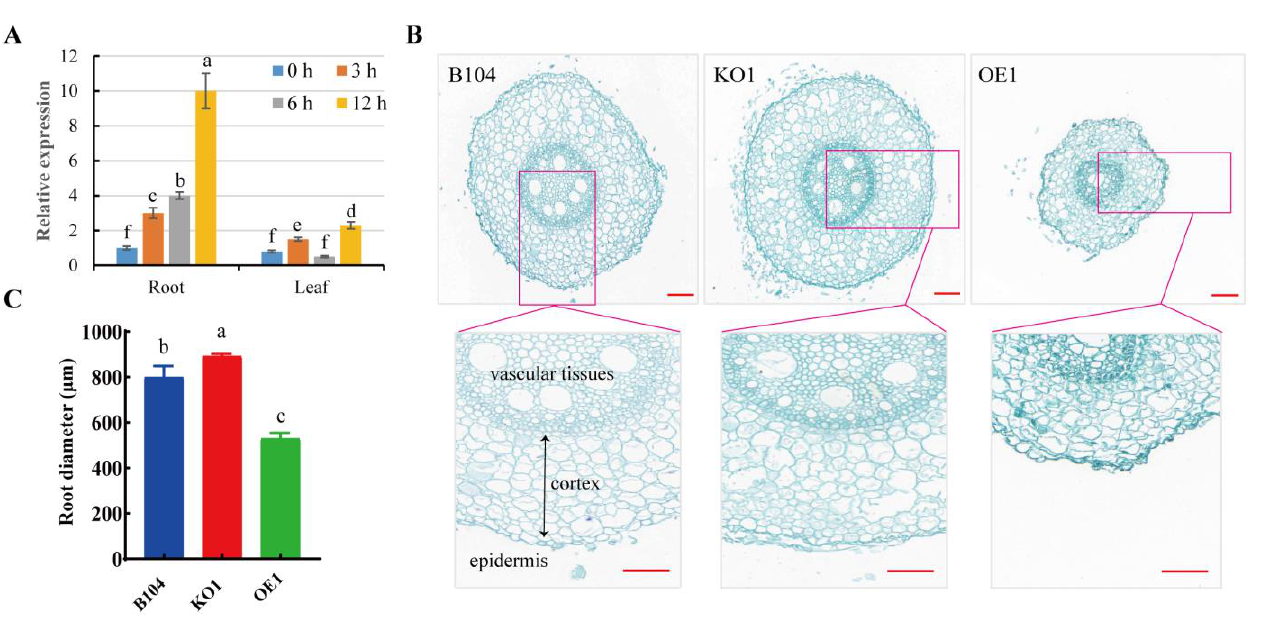
Figure 9. Comparison of PCP expression levels and root microscopic structure among WT and transgenic lines. ( A ) Relative expression levels of PCP in root and leaf of B104 under osmotic stress. ( B ) Cross section of root. Root sections were sampled at 30–40 mm from tips. Scale bar: 100 μm. ( C ) Diameter of roots. Data represent means ± SD of three biological replicates. Significant differences are indicated with different letters ( p 0.05, one - way ANOVA, Duncan’s multiple range test).